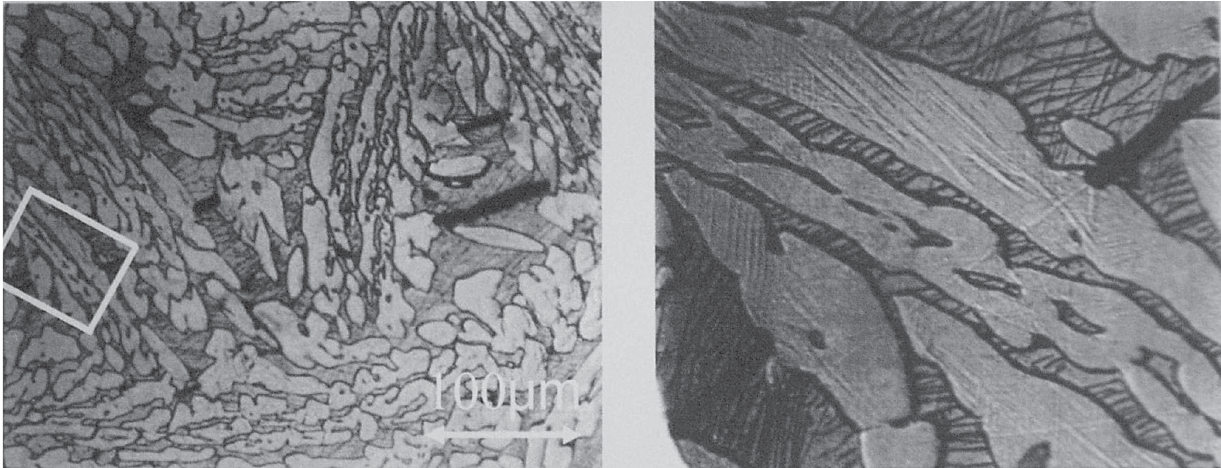
Figure 2. Deformation and cracking of a F32 T1 unnotched specimen after fracture. A magnified detail can be seen at